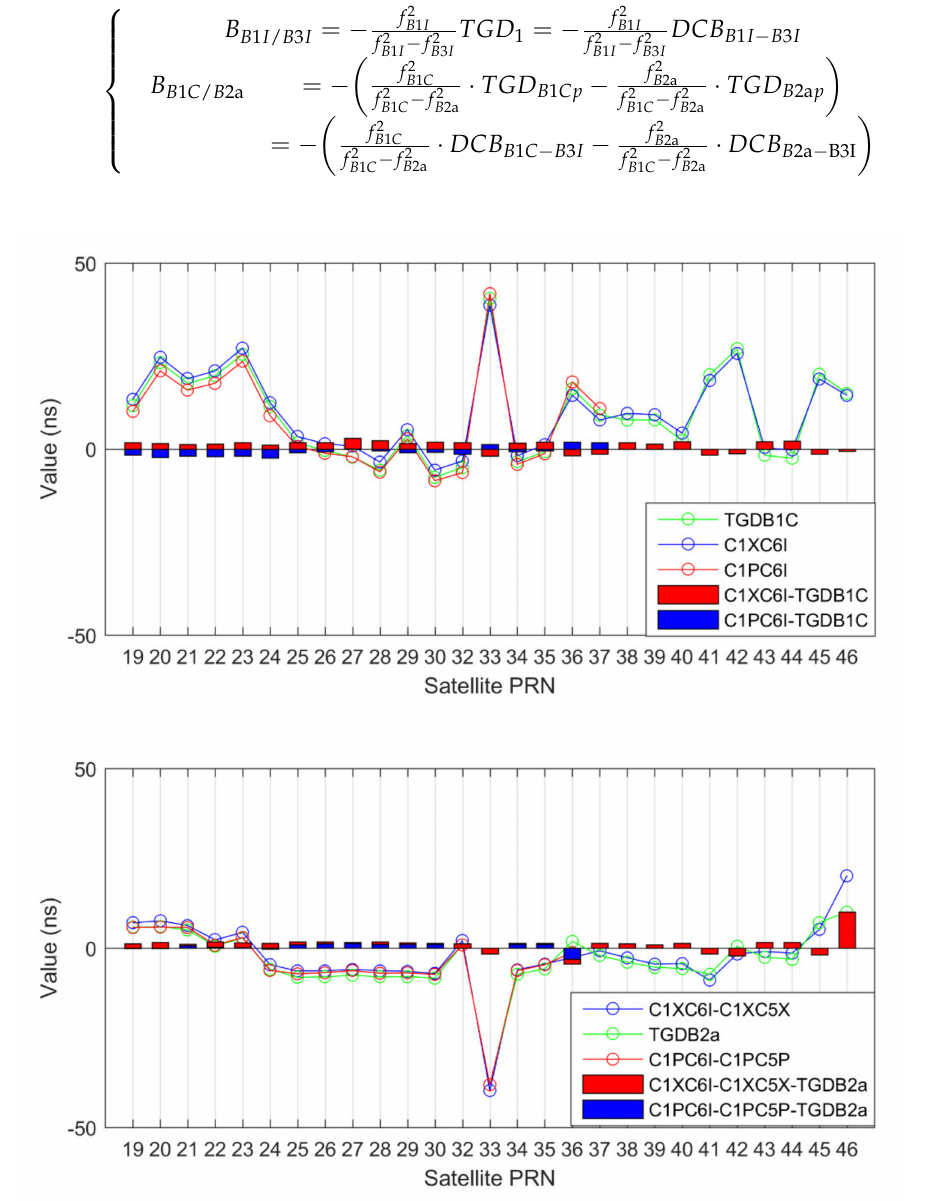
Figure 3. Comparison of BDS-3 broadcast TGD with